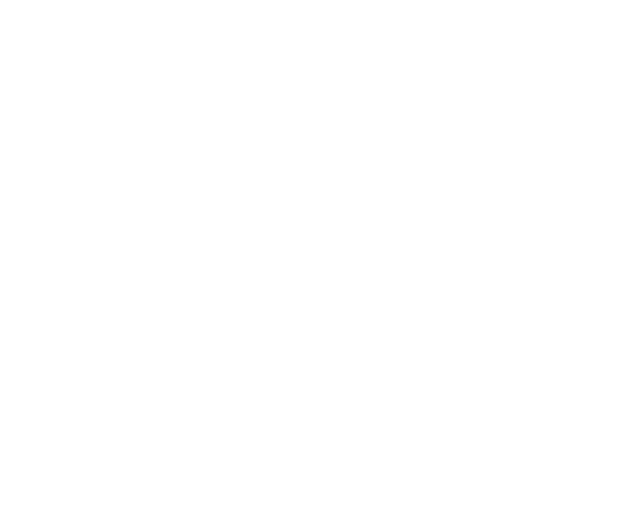
Figure 14. Comparison of force–displacement curves obtained from the simulation and the experi- ment under different deformation conditions: ( a ) 350 ◦ C; ( b ) 400 ◦ C; ( c ) 450 ◦ C.